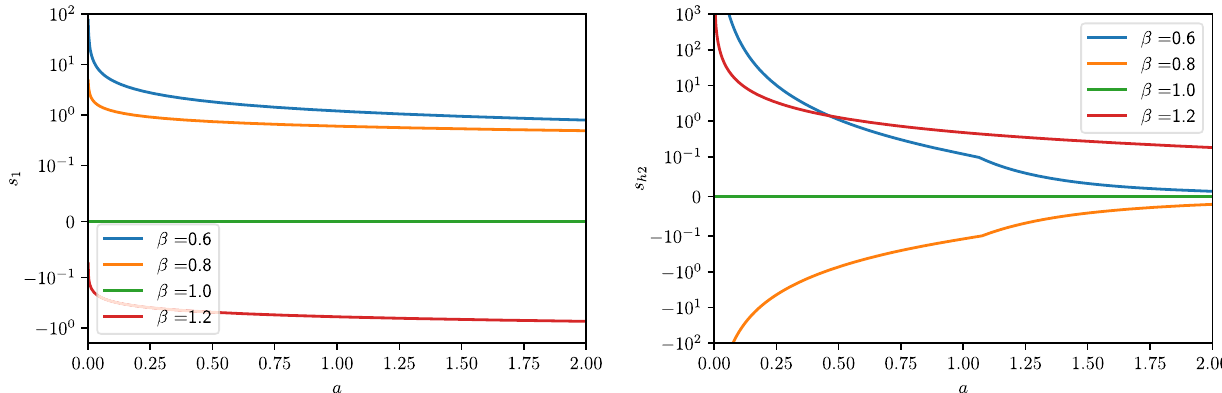
Fig. 3 Model M 3 : s 1 and s h 2 as function of scale factor for some values of β . We have used a mixed log-linear scale in order to view both asymptotic behaviour and zero crossing